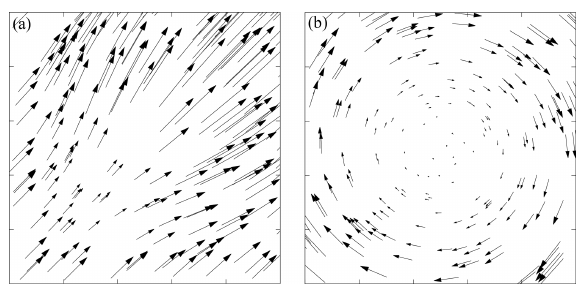
Figure 11. Forcing fields of (a) wind velocity and (b) ocean velocity used in a square domain test